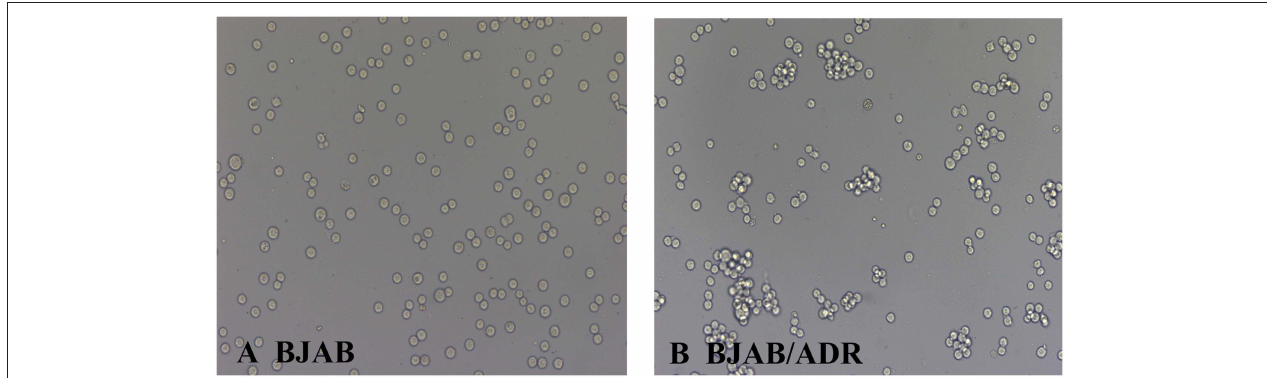
FIGURE 1 | Morphological characteristics of BJAB and BJAB/ADR cells. BJAB cells (A) and BJAB/ADR cells (B) were observed under an optical microscope (original magnification × 200). Compared with BJAB cells, BJAB/ADR cells tended to grow in clusters.